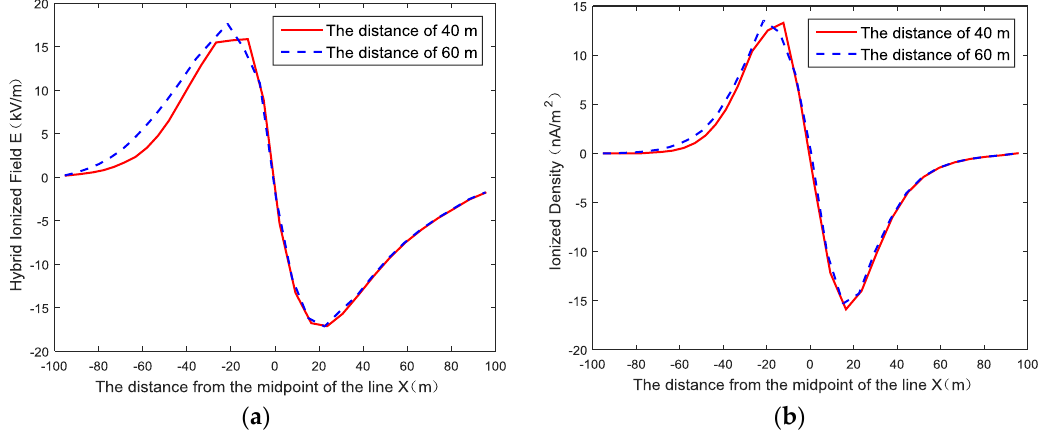
Figure 9. Comparison of calculation between 40 m and 60 m. ( a ) Hybrid ionized field. ( b ) Ion current density. Table 1. The value and growth rate of calculation results when the approach distance is changed.